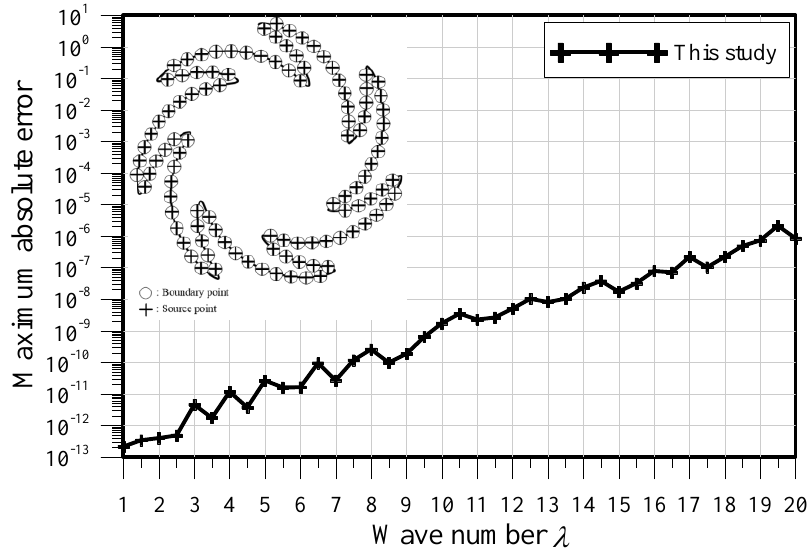
Figure 5. MAE versus the wave number λ .